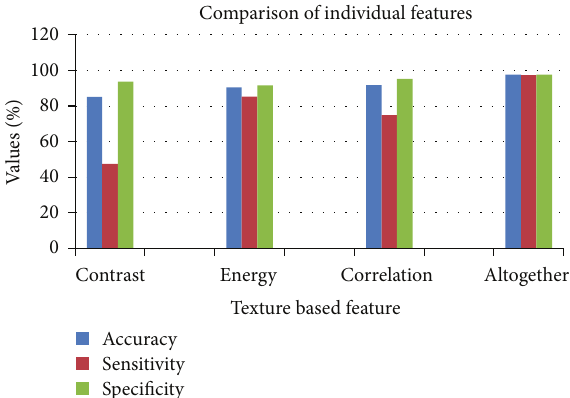
Figure 10: Comparison of individual texture based features in terms of accuracy, sensitivity, and